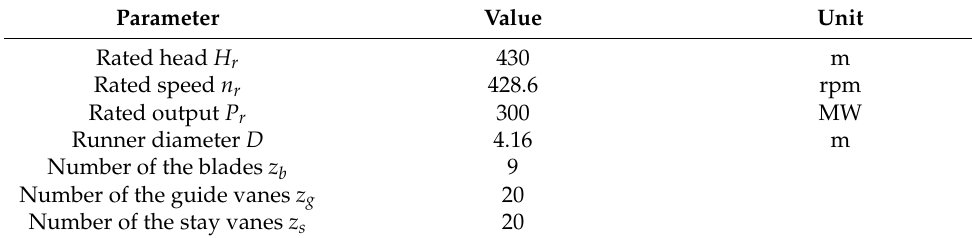
Figure 1. Structural model of the researched pump-turbine. Table 1. Main parameters of the researched turbine unit.